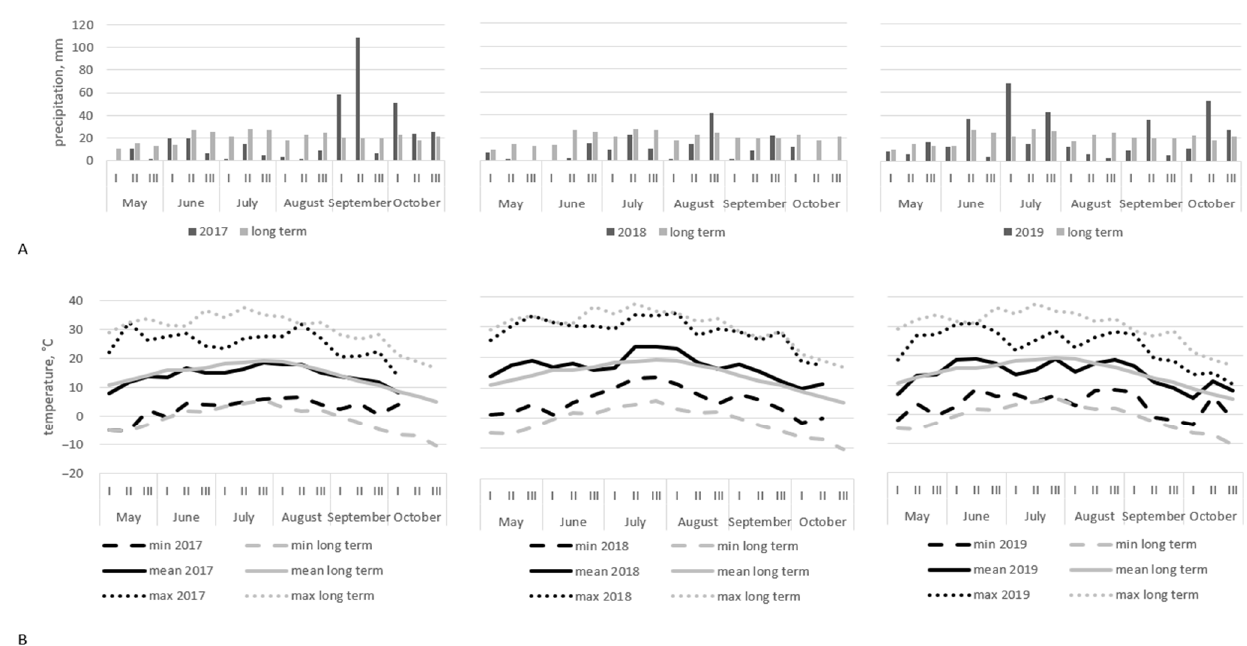
Figure 1. Meteorological data for the 2017–2019 growing seasons (per 10-day periods) and long-term observations (for 30-year period) in Latvia. ( A )—precipitation, ( B )—temperature. The average monthly air temperature during 2017–2019 seasons were 6.2–17 ◦ C, 10.0–21.1 ◦